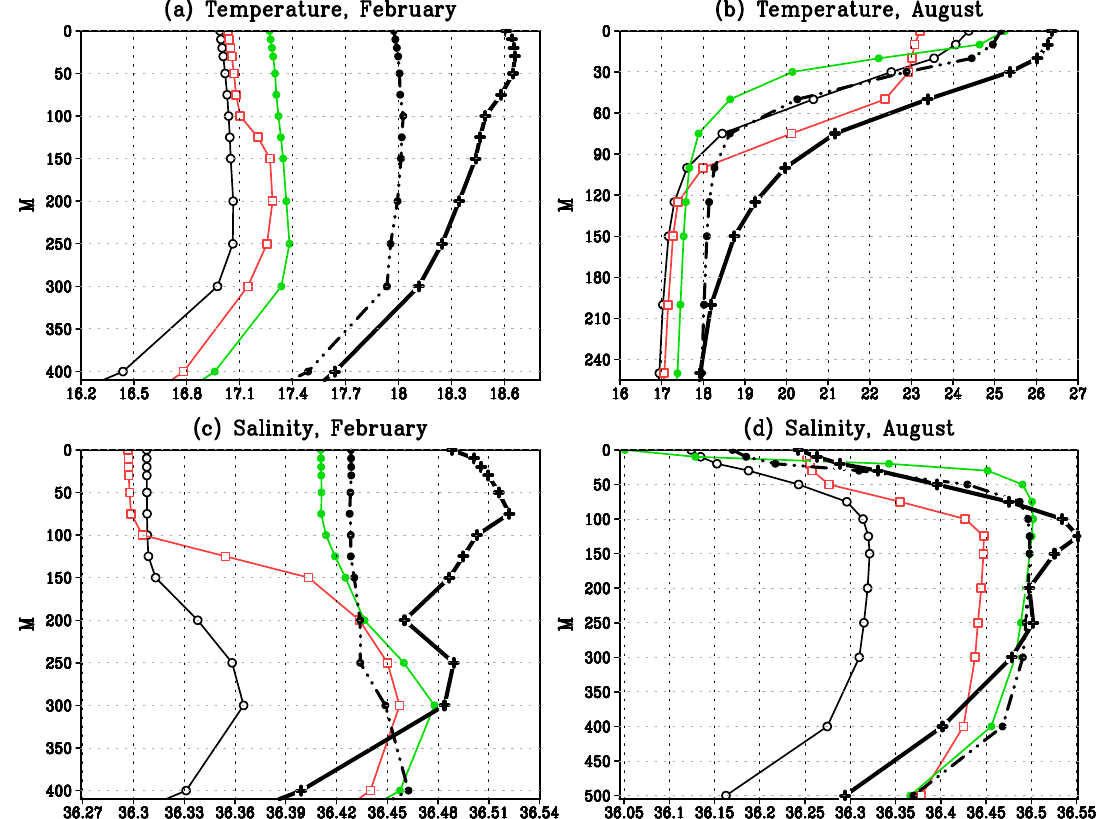
Figure 3. T (in ◦ C) and S (in PSU) profiles for February and August averaged for 1980–2009 in the Sargasso Sea (center of the one-degree model cell near 36 ◦ N, 51 ◦ W): the columns are February ( left ) and August ( right ), rows are temperature ( top ) and salinity ( bottom ). Black solid thick line with crosses represents the climate; Green solid line with dark circles—EX1; Black dash/double dot line with dark circles—EX2; Black solid thin line with hollow circles—EX3; Red solid line with hollow squares—EX4. Significant deviations of profiles T and S from climatic values for the EX1 are eliminated for the EX2 in the central part of the North Atlantic Current (Figure 4). These deviations were not for the first 20 years of the EX1. Thermocline is very well reproduced in the August for EX2 (Figure 4b). Temperature profiles are better simulated in the EX2 relative to the other experiments in February and August (Figure 4a,b). The main drawback of the parameterization EX4 is high deviation of salinity profiles from the climatic data (Figure 4c,d). The salinity profiles are the best reproduced in the EX2 and EX3 (Figure